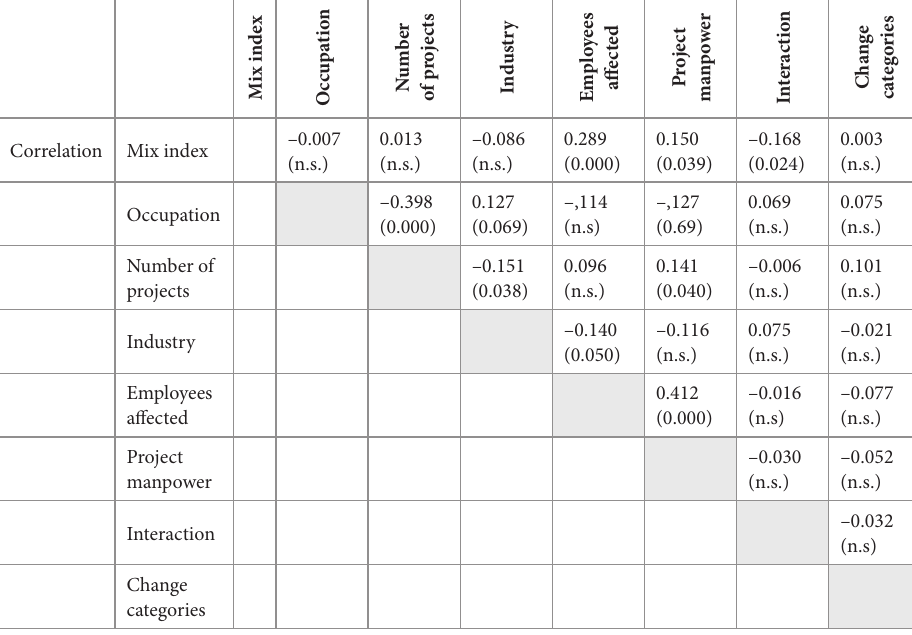
Table 3. Correlations between context variables and mix